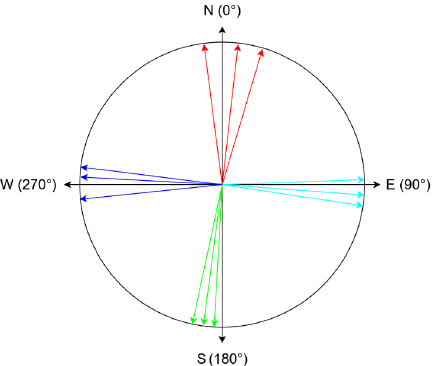
Figure 6. Example of user directions used in the clustering